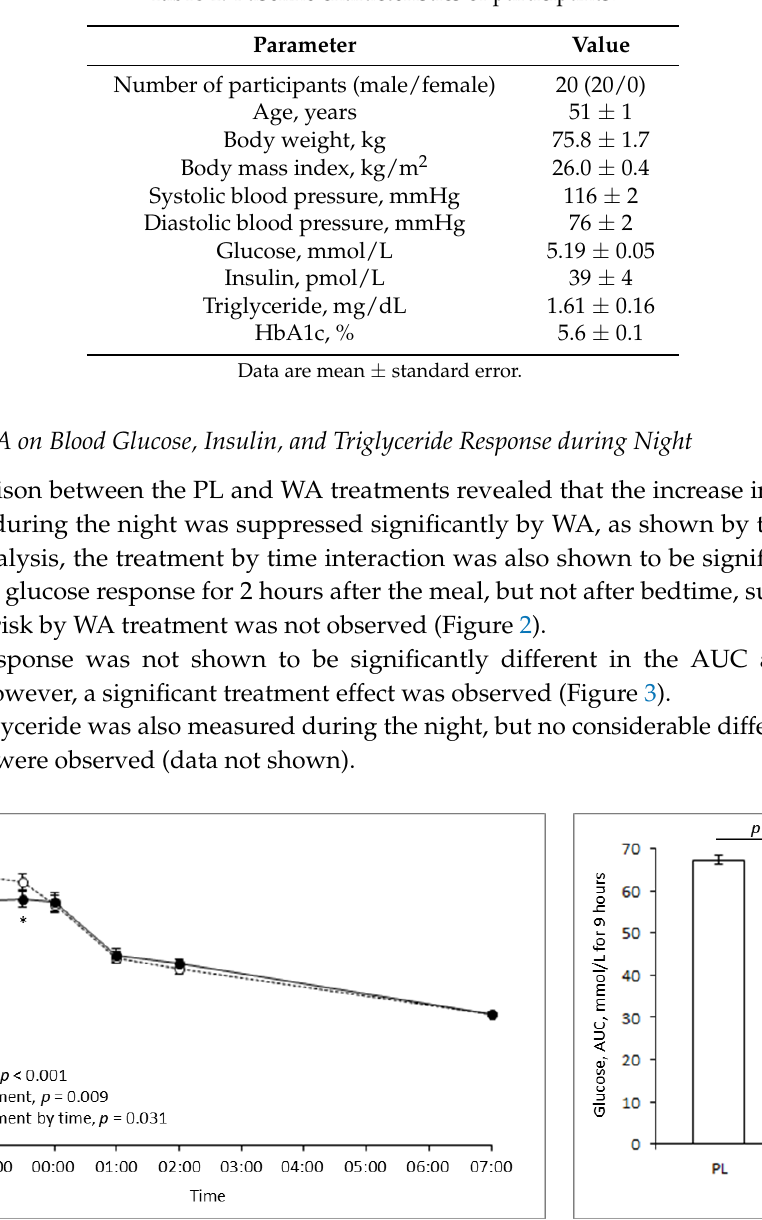
Table 1. Baseline characteristics of participants.